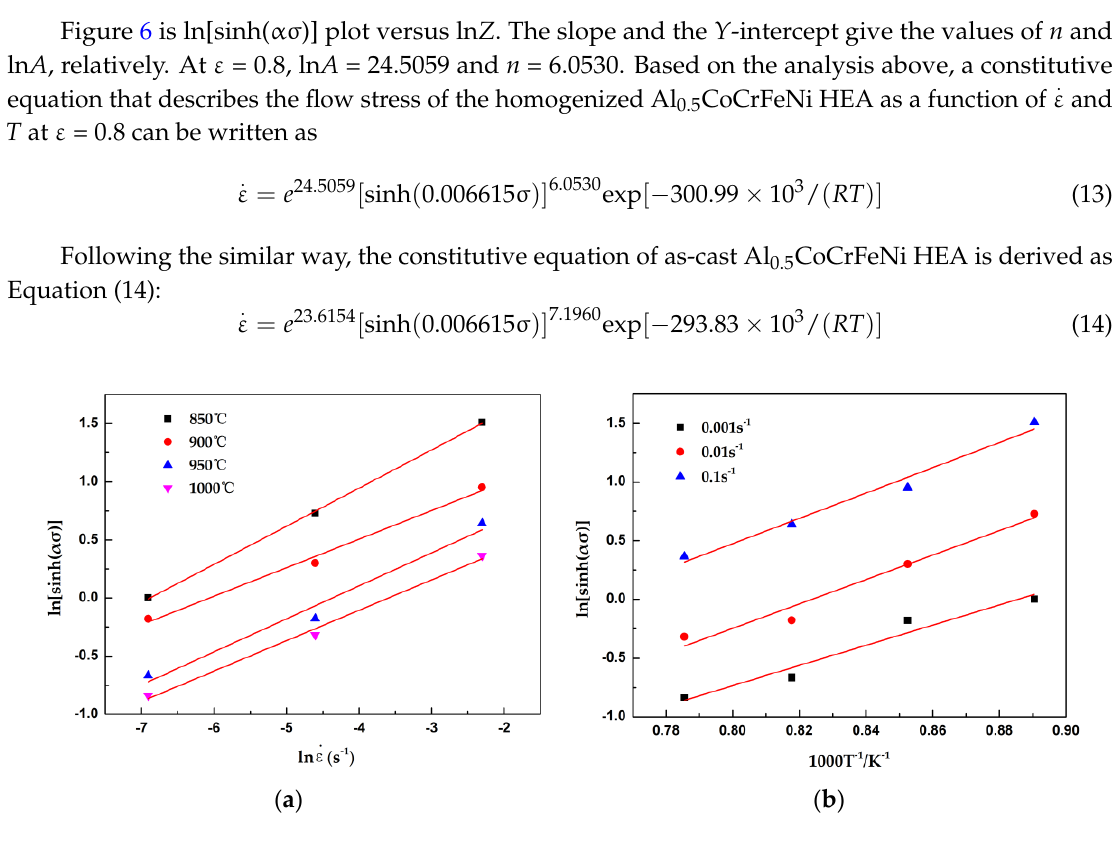
Figure 6. Plot of ln Z –ln[sinh(ασ)].